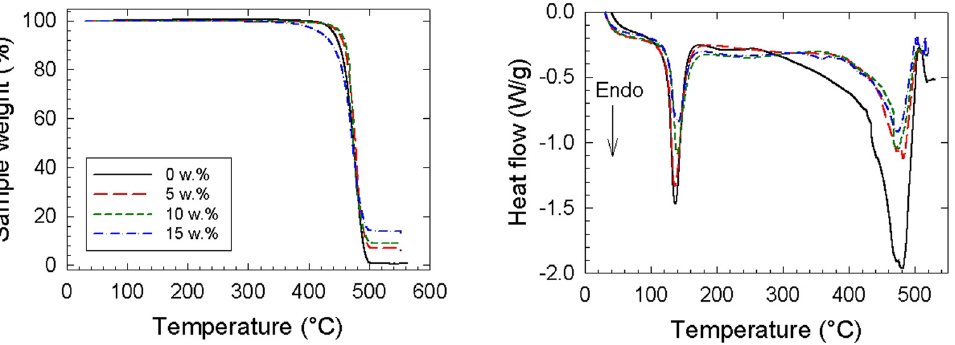
Figure 8: Results of the TGDTA thermal analysis of the studied perlite/HDPE composites. Inset: Perlite concentration.